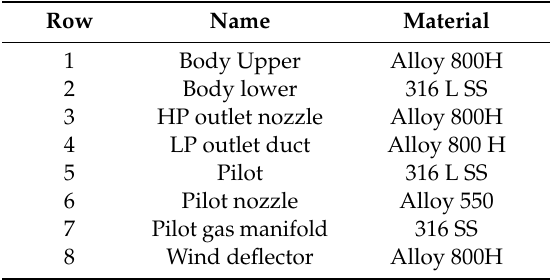
Table 1. The material specification for different components of the flare .